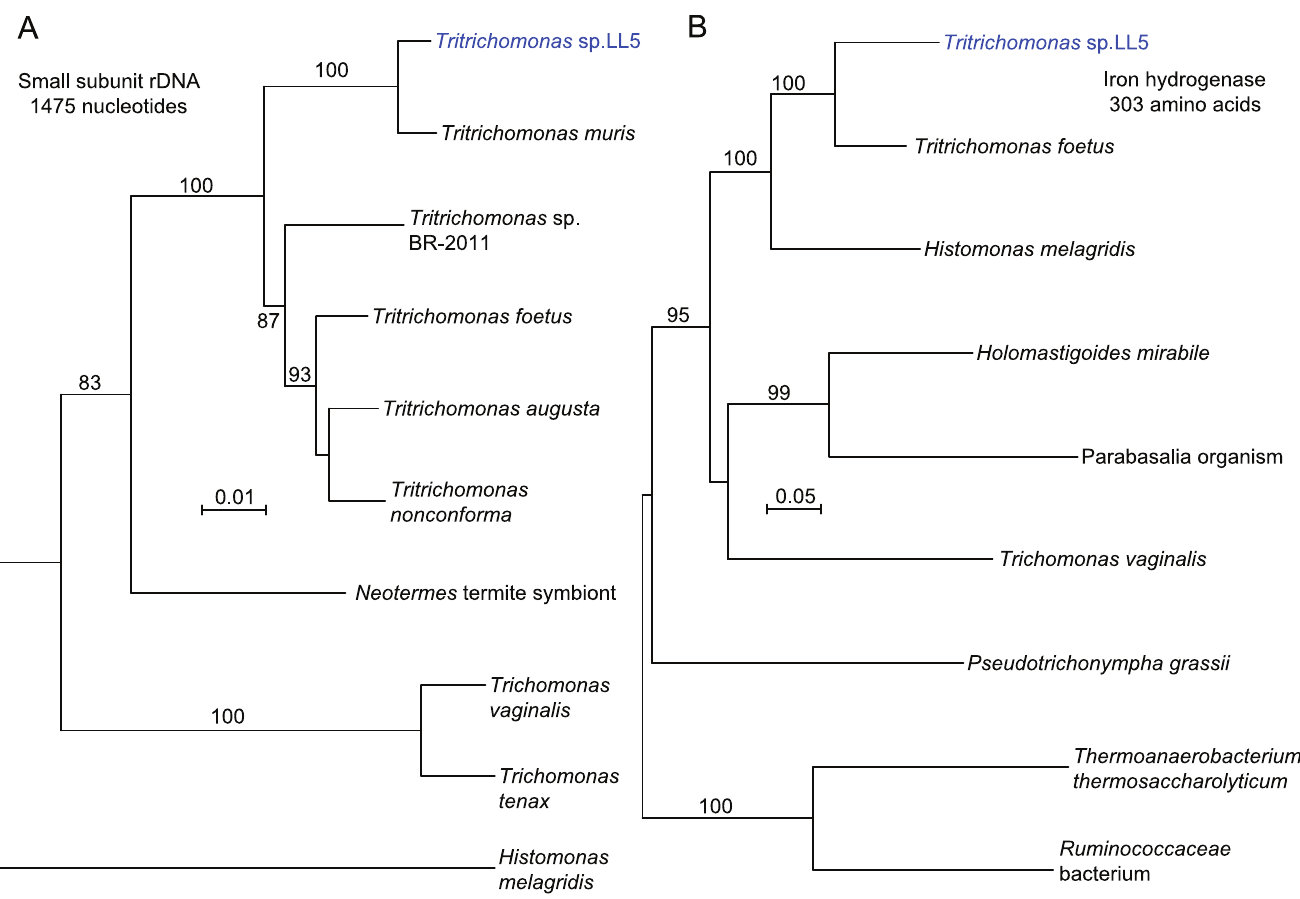
Fig 6. Neighbor-joining distance phylograms of nucleotide (panel A) or amino acid (panel B) partial sequences of small subunit ribosomal RNA gene (rDNA) (panel A) and iron hydrogenase protein (panel B) of Tritrichomonas sp. LL5 of P . leucopus and selected other parabasilids and other microbes. The distance criteria were observed differences for nucleotide alignment and Poisson for amino acid alignment. The scales for distance are shown in each panel. Percent bootstrap (100 iterations) support values of � 80% at a node are shown.